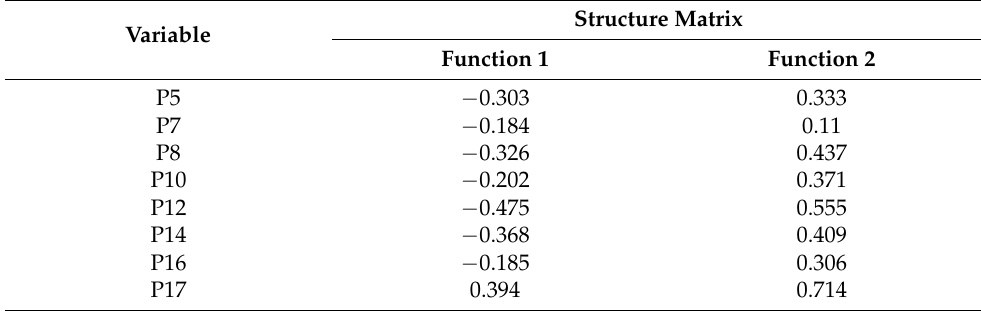
Table 4. Structure matrix table with coefficients for the peak variables used in discrimination analysis.